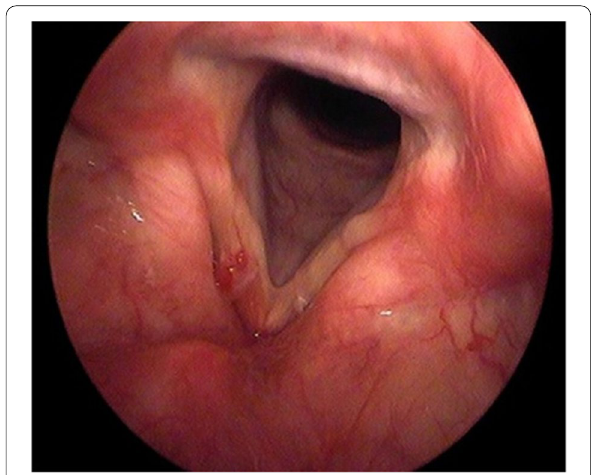
Fig. 1 Laryngoscopic picture showing moderate to severe LPR associated with right vocal